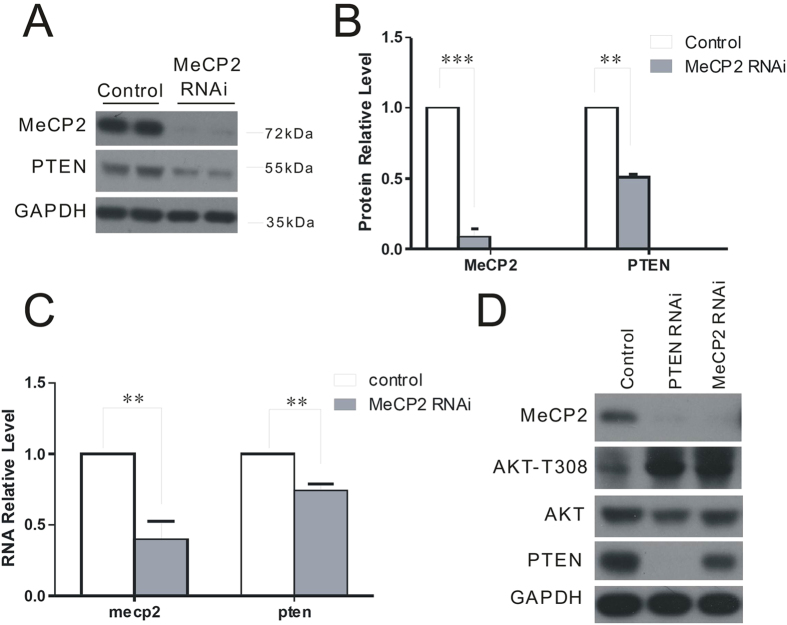
MeCP2 deficiency down-regulates PTEN.(A) Primary cultured neurons were transduced with lentivirus expressing GFP (control) or MeCP2 RNAi (for Mecp2 knockdown). PTEN protein expression was down regulated in MeCP2-RNAi neurons. Glyceraldehyde phosphate dehydrogenase was used as a loading control. (B) MeCP2 and PTEN protein levels in (A) were quantified using Image J. (C)
Mecp2 and Pten RNA levels were analyzed by qPCR. (D) AKT T308 phosphorylation status was increased by PTEN RNAi or MeCP2 RNAi compared with controls.